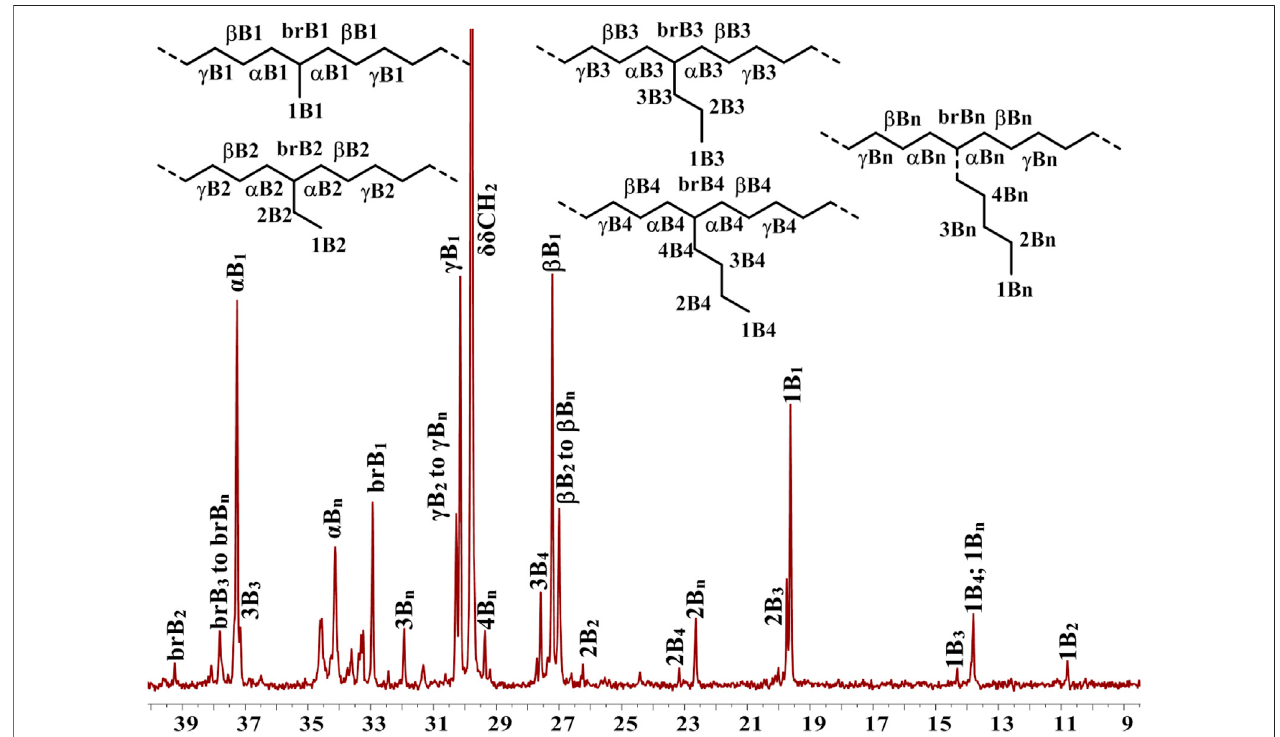
FIGURE 7 | Detailed analysis of 13 C NMR spectrum of branched polyethylene obtained by using Ni5 at 70 ° C ( Table 1 , entry 15). Assignments are numbered according to ref. 49-51. Branches are labeled as xBy, where y is the branch length and x is the carbon, starting from the methyl end with 1. The methine groups for the different branch lengths are labeled with